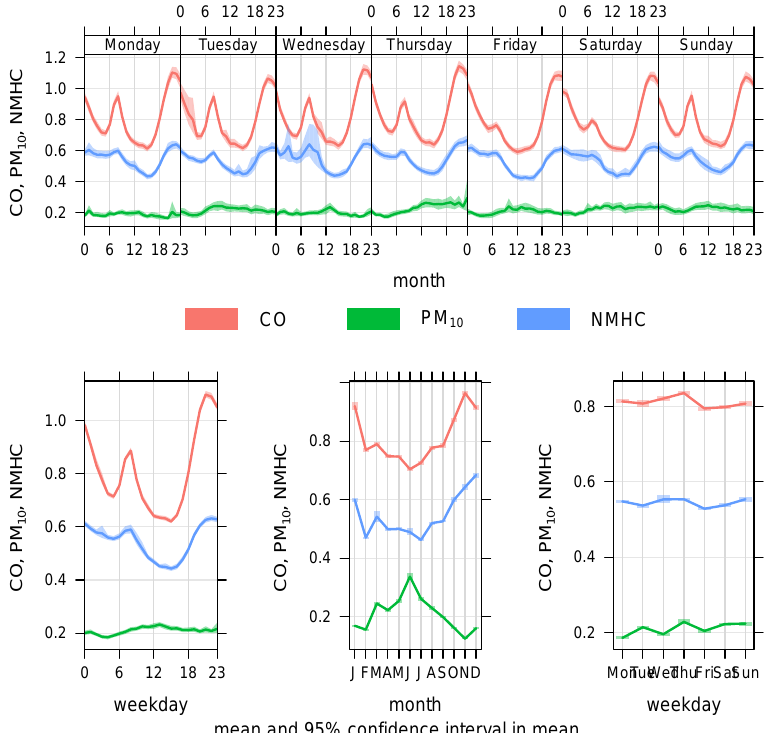
Figure 5. Temporal variation of the Studied Pollutants according to the station site from 2012 to 2017 for CO , PM 10 and NMHC —EPA